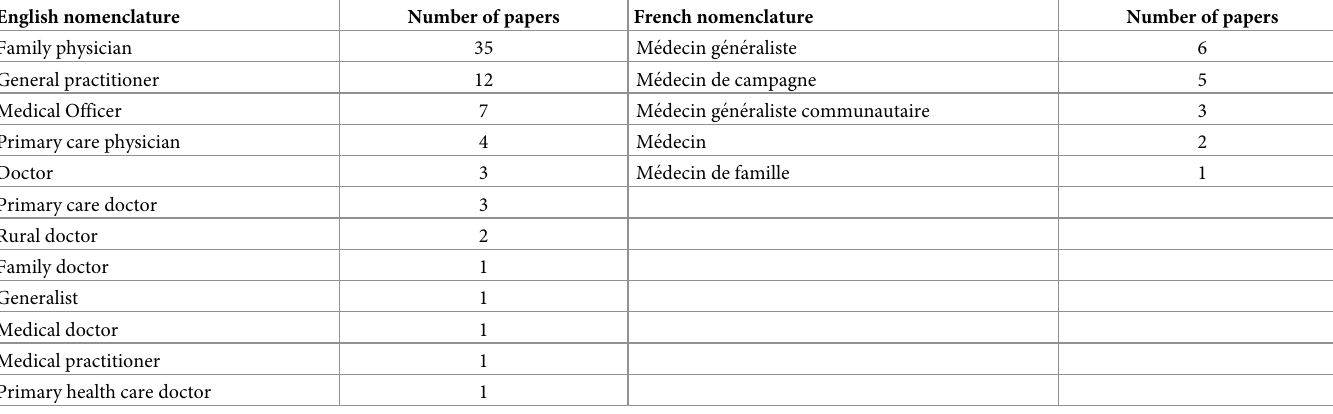
Table 3. Nomenclatures of primary care physicians in sub-Saharan